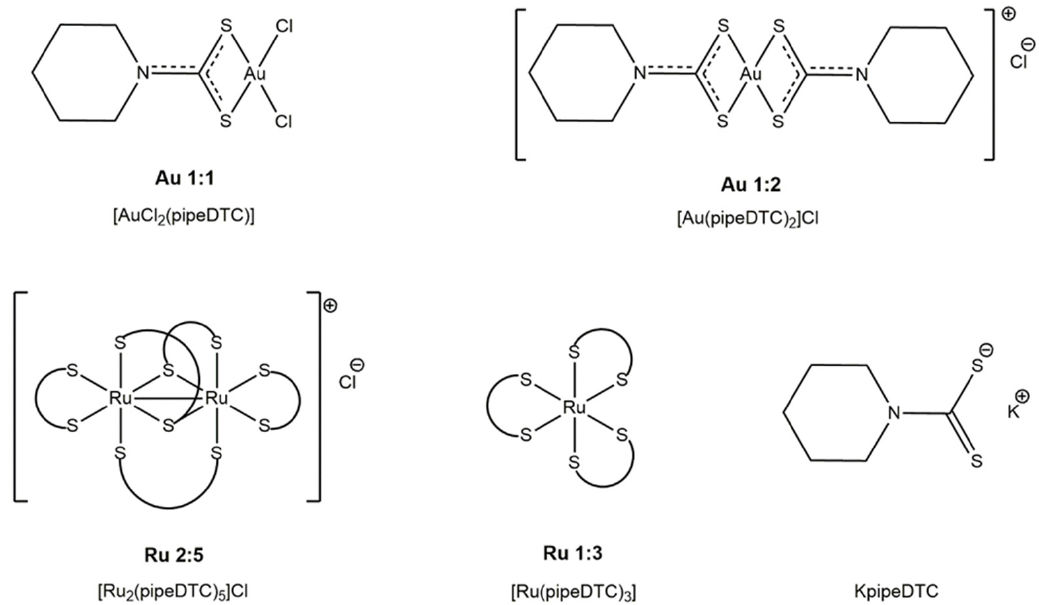
Figure 1. Chemical structures of the ligand K pipeDTC and the gold and ruthenium piperidine dithiocarbamato derivatives. The compounds’ names and their abbreviations are reported here.